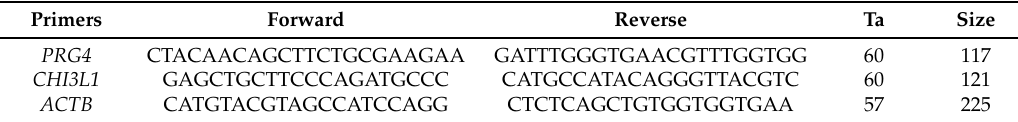
Table 2. Primers used in gene expression analysis by real-time PCR (qRT-PCR). PRG4 : proteoglycan 4; ACTB: β -Actin; Ta: thymine and